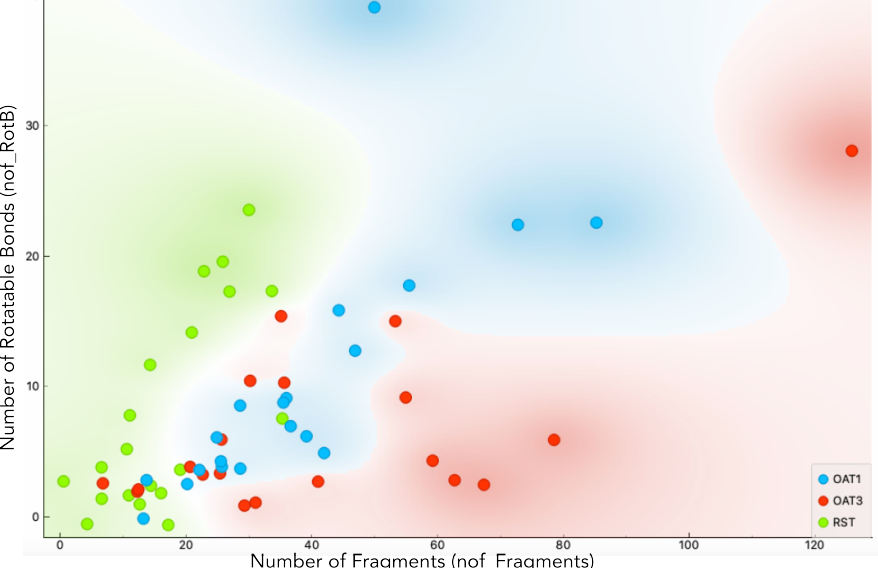
Figure 2. The scatter plot indicates how two molecular properties, the number of fragments (abscissa) and the number of rotatable bonds (ordinate), provide a reasonable separation of metabolites elevated in the 3 knockouts. Green circles represent the RST KO and the red and blue circles correspond to the Oat1 and Oat3 KO,